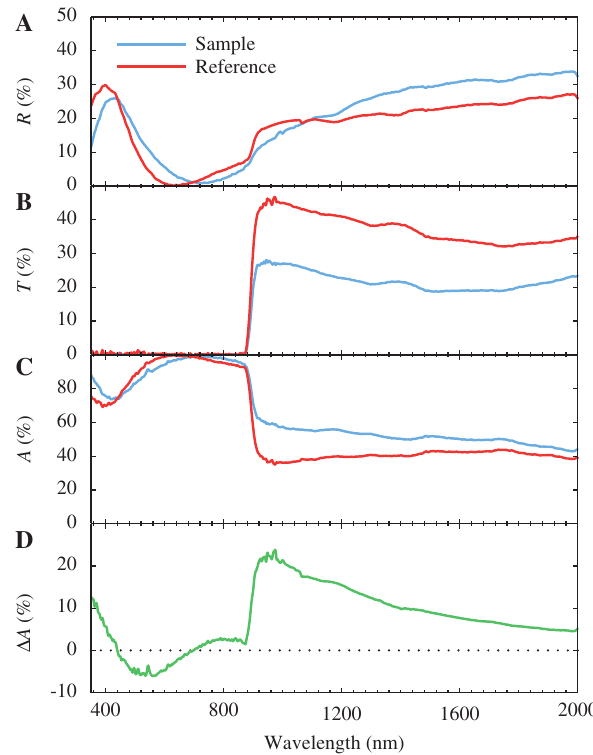
Figure 3: Spectral characterization of